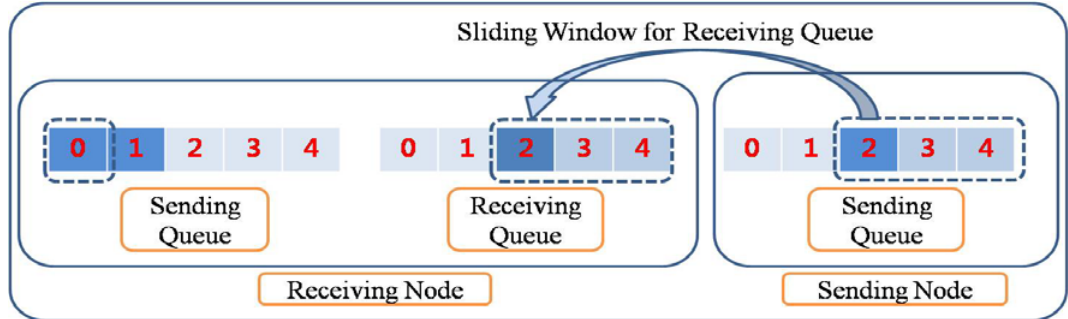
Figure 2. Sliding window for receiving queue. Sliding window for receiving queue